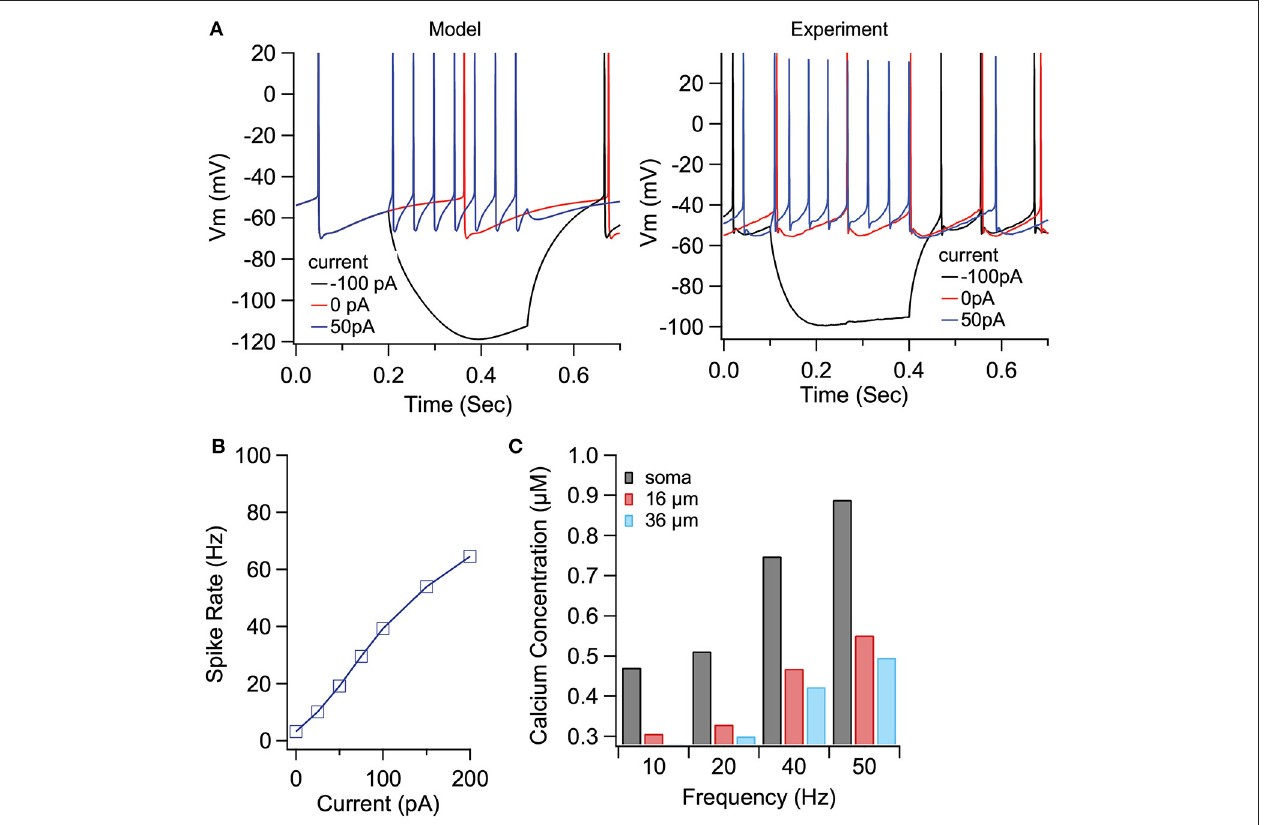
FIGURE 7 | Optimized compartmental model for a neuron in the EP. (A) Parameter optimization to EP neuron data produces multi-compartmental EP neuron model with realistic spiking and rectification characteristics. (A) Sample traces of EP neuron model (left) and data (right) showing spontaneous activity and response to hyerpolarizing current injection. (B) Firing frequency vs. current injection is similar to that measured experimentally. (C) Calcium concentration vs. distance from soma and firing frequency is similar to that measured